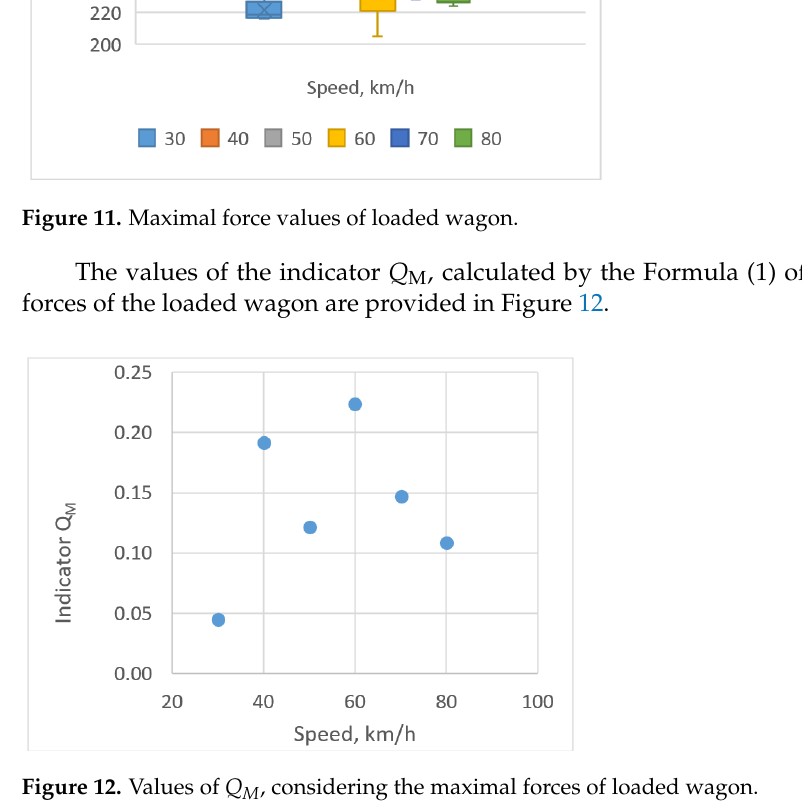
Figure 13. Values of maximal forces of unloaded goods wagon. The chart of Figure 13 shows that the maximal scatter of the force values is at a speed level of 70 km/h. The values of Q M , calculated according to Formula (1) for the maximal forces when the goods wagon is unloaded, are given in Figure 14.